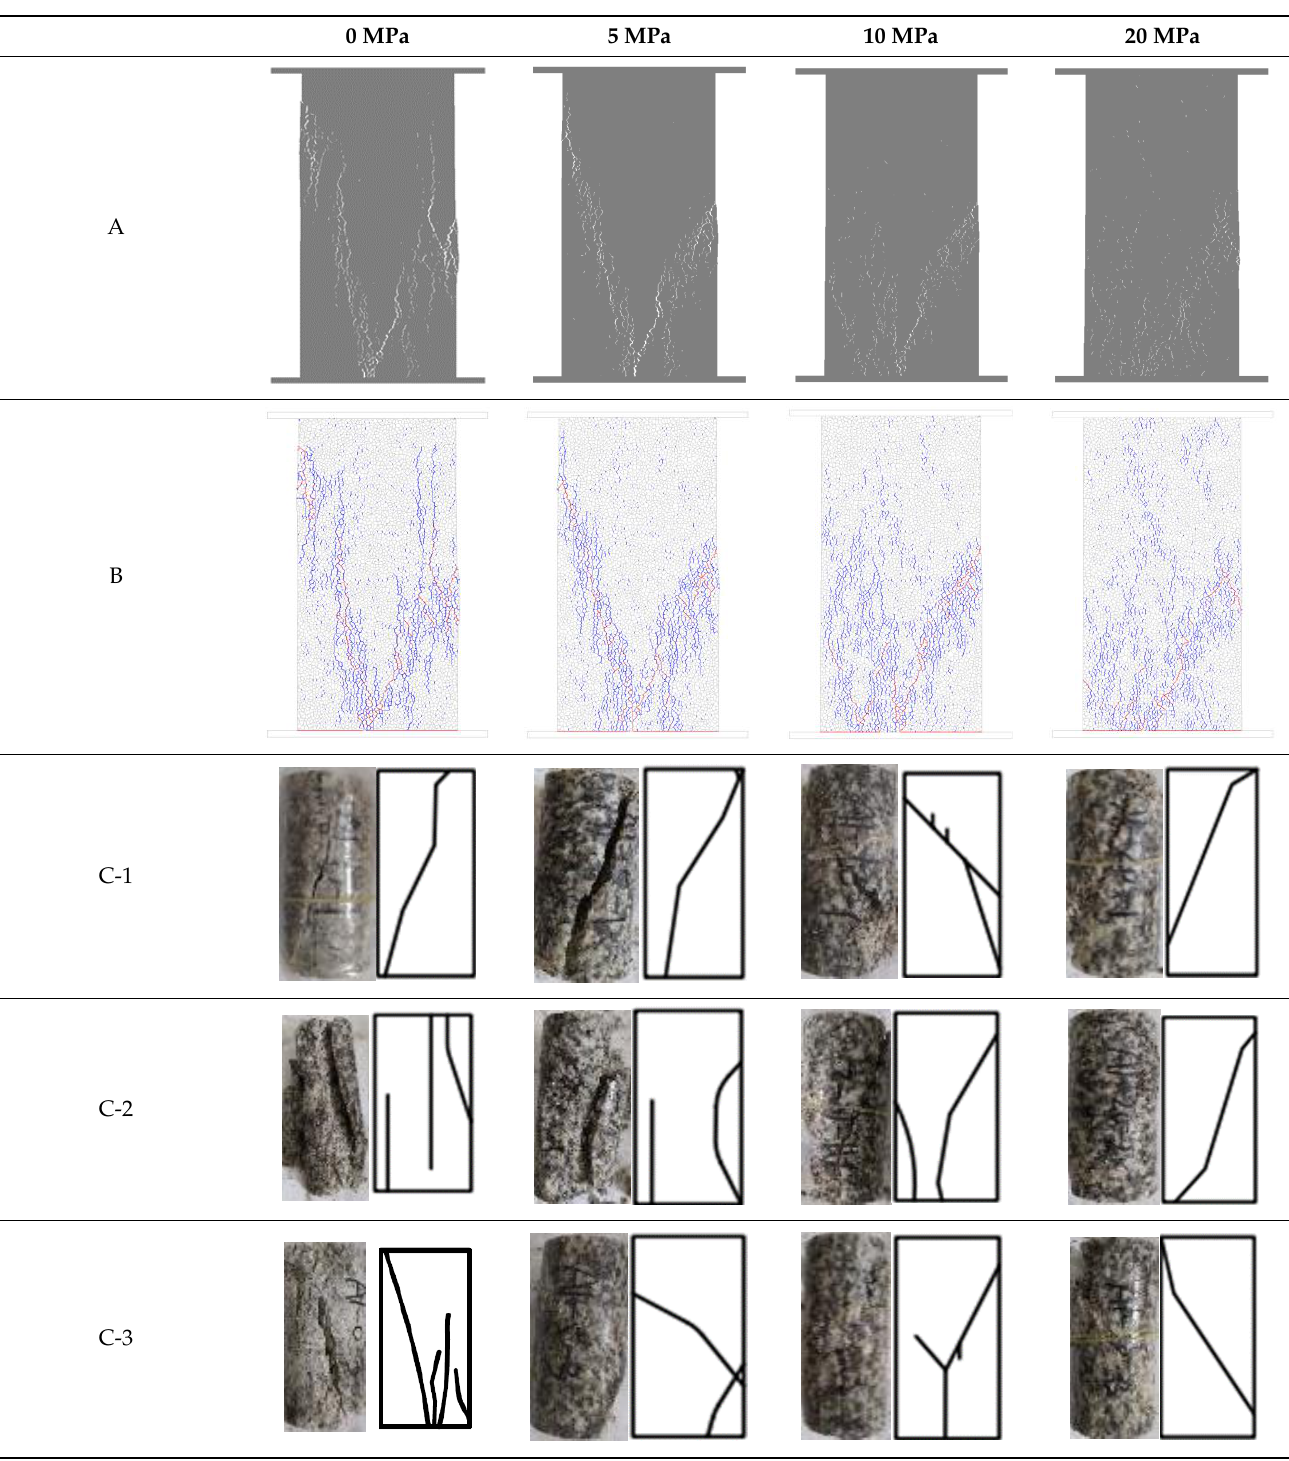
Figure 20. Relationship between peak strength and damage strength ratio under various. Table 6. Comparison of macroscopic rupture between numerical simulation and experiment under different confining pressure conditions. Note: Group A represents macroscopic fracture of numerical simulation; in Group B, blue and red colors represent tensile and shear cracks, respectively; Group C: 1–3, macroscopic fracture and sketch of test sample.